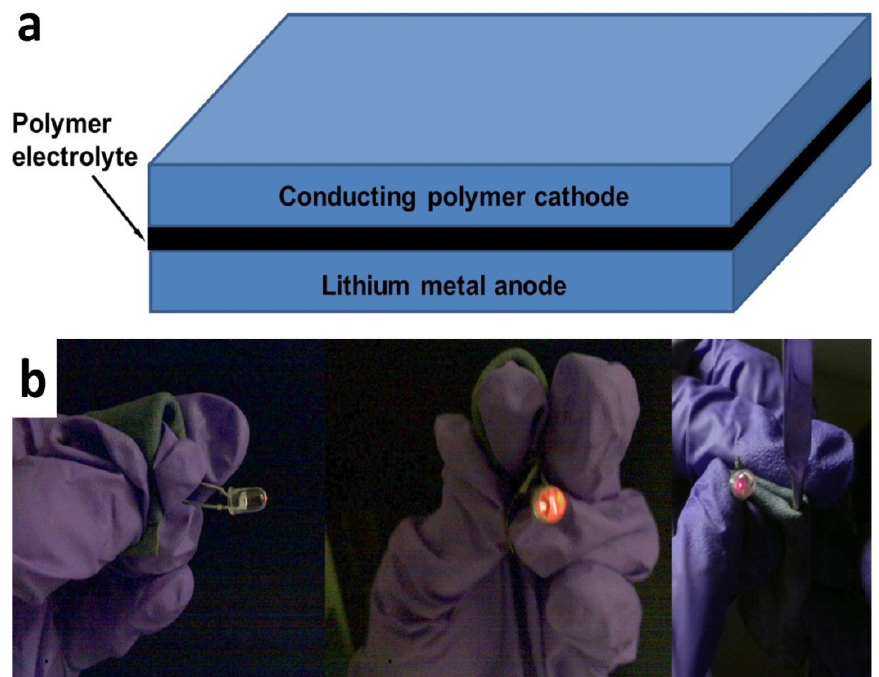
Figure 2. ( a ) Structure of the textile battery and ( b ) flexible and fully rollable batteries made from PEDOT soaked textile that can light up an LED.